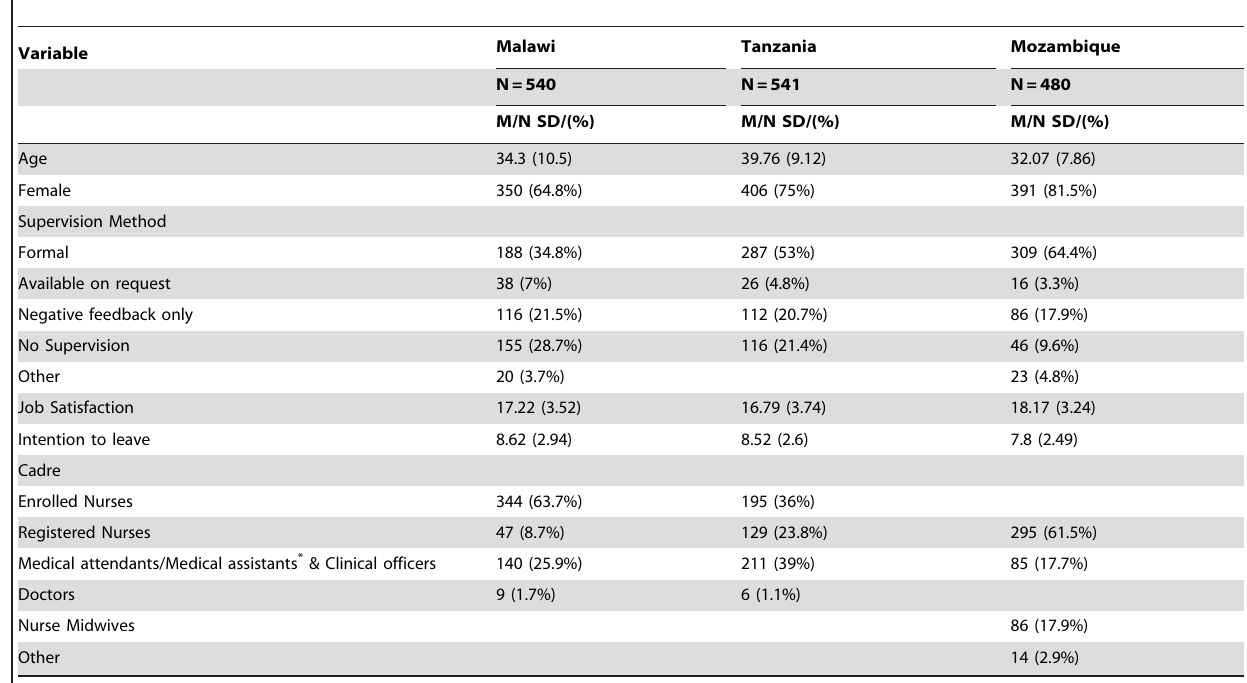
Table 1. Descriptive statistics for the demographic characteristics and adequacy of supervision, job satisfaction and intention to leave ratings from Malawi, Tanzania, and